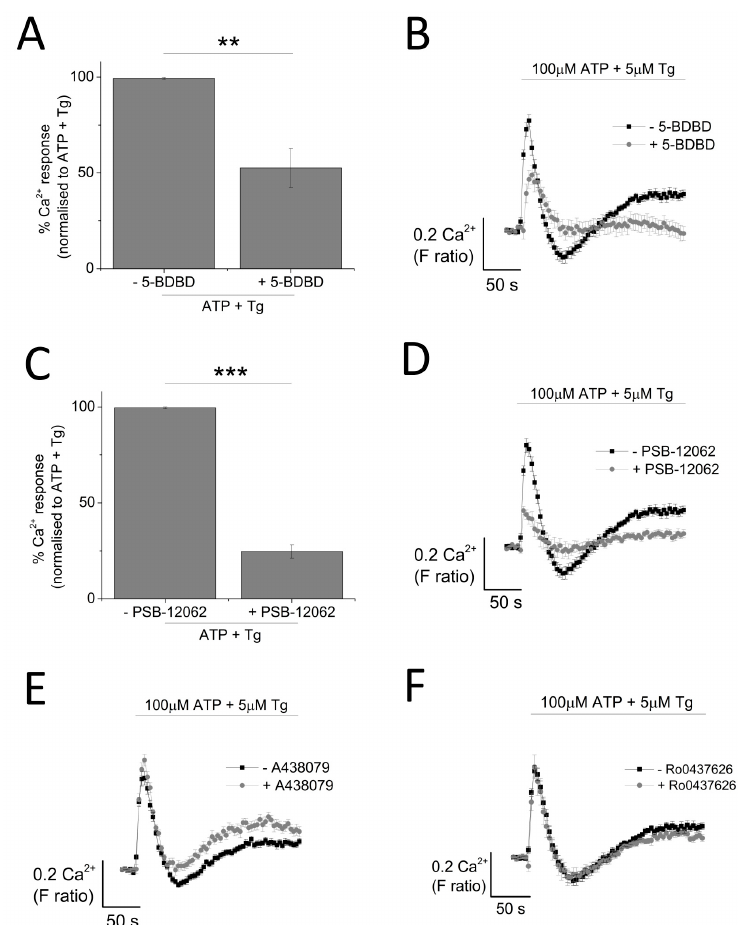
Figure 5. Effect of selective P2X receptor antagonists on Tg-resistant ATP-evoked Ca 2+ response in THP-1 differentiated macrophages. ( A , B ) effect of P2X 4 receptor antagonist (10 µ M 5-BDBD) on magnitude of Ca 2+ response and net calcium movement on Tg-resistant Ca 2+ response ( n = 3); ( C , D ) effect of P2X 4 receptor antagonist (10 µ M PSB-12062) on magnitude of Ca 2+ response and net calcium movement on Tg-resistant Ca 2+ response ( n = 3); ( E ) effect of P2X 7 receptor antagonist (5 µ M A438079) represented as time response traces ( n = 3); ( F ) effect of P2X 1 receptor antagonist (30 µ M Ro0437626) represented as time response traces ( n = 3). Asterisks include significant changes towards control (*** p < 0.001, ** p < 0.01).